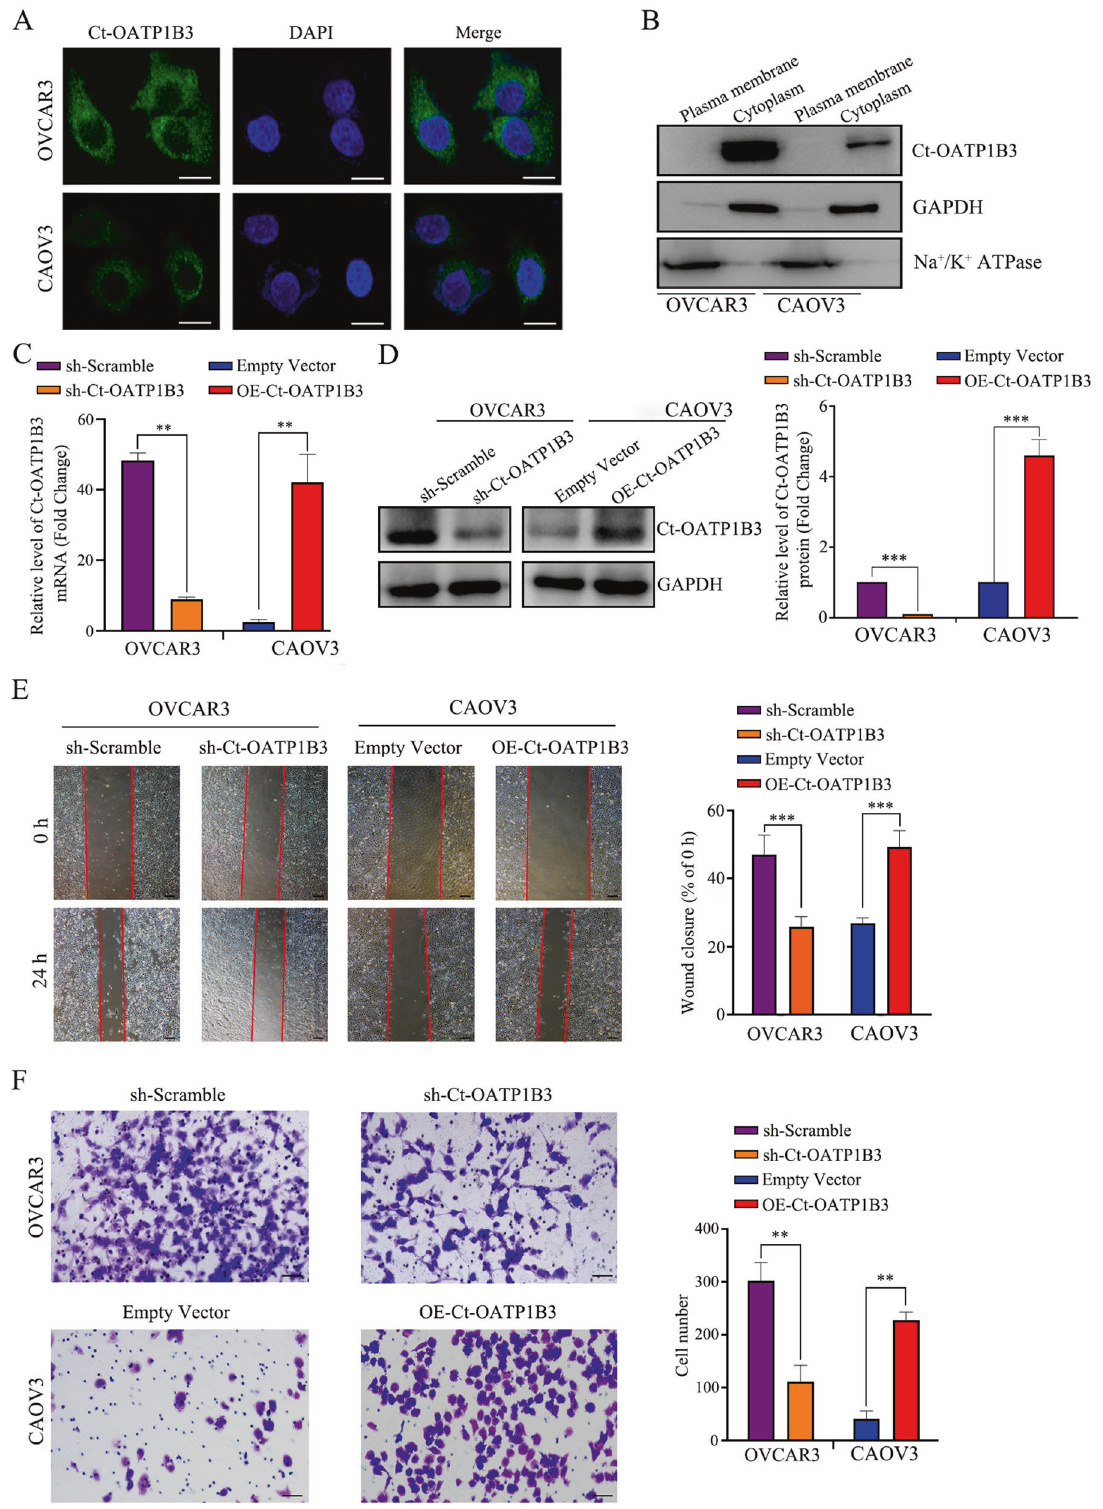
Fig. 2 Ct-OATP1B3 promotes the invasion and migration of HGSOC cells. A , B Subcellular localization of Ct-OATP1B3 in HGSOC cells. Scale bar, 25 μ m. C , D Ct-OATP1B3 expression in HGSOC cells after Ct-OATP1B3 overexpression or knockdown. E , F Ct-OATP1B3 promotes the migration ( E , scale bar, 500 μ m) and invasion ( F , scale bar, 200 μ m) of HGSOC cells. ** P < 0.01, *** P < 0.001.